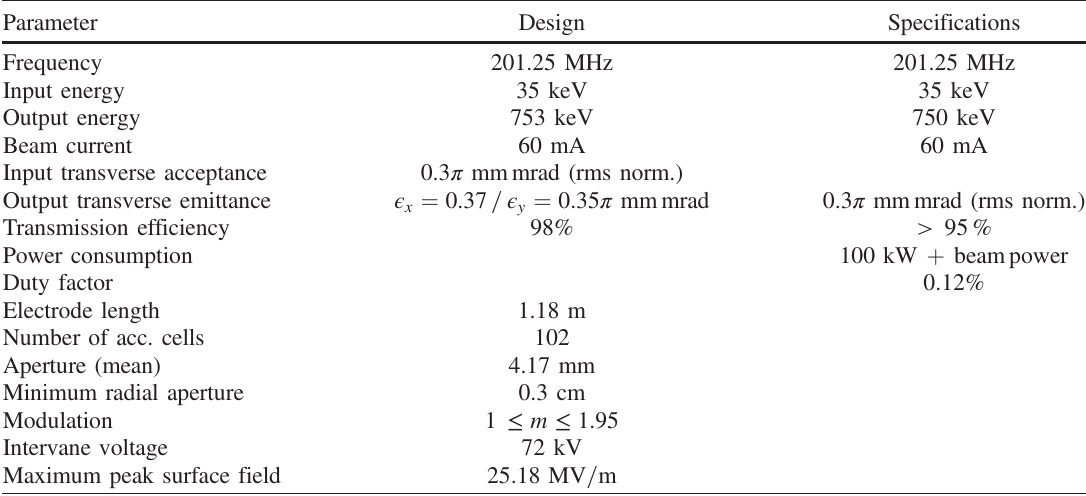
TABLE I. Design Parameters of the FNAL RFQ.